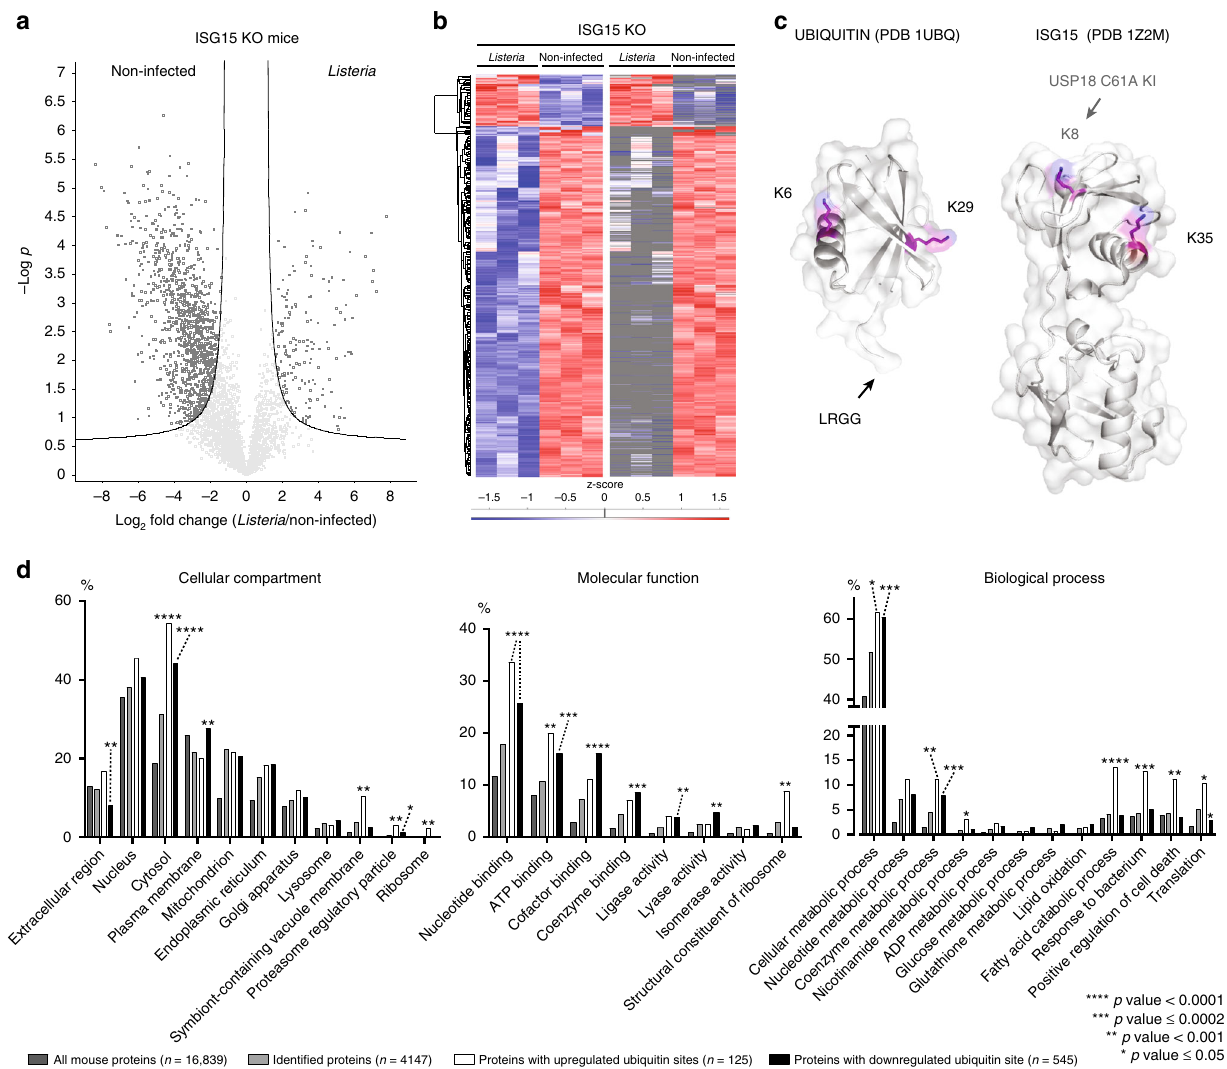
Fig. 3 Loss of ubiquitin sites following infection and evidence for mixed ISG15/Ubiquitin chains. a Volcano plot showing signi fi cantly regulated ubiquitin sites upon Listeria infection of Isg15 − / − animals. The fold change (in log2) of each GlyGly(K) site is shown on the x -axis, while the statistical signi fi cance ( − log P -value) is shown on the y -axis. In total, 168 GlyGly(K) sites were signi fi cantly upregulated during infection, while 1138 sites were downregulated (Supplementary Data 3). b Heatmap representation of signi fi cantly up- and downregulated ubiquitin sites after non-supervised hierarchical clustering. On the right side, the heatmap is shown with missing values in gray (Supplementary Data 4). c Crystal structures of ubiquitin and ISG15 with modi fi ed lysines highlighted. K6 and K29 of ubiquitin are modi fi ed following bacterial infection in wild-type animals. K35 of ISG15 is modi fi ed following bacterial infection in wild-type animals, and K8 is modi fi ed following infection in USP18 C61A/C61A animals. d GO cellular compartment analysis of ubiquitylated proteins (clusters 3 and 4) relative to all proteins identi fi ed in the analysis (light gray) and all mouse proteins in the Uniprot/Swiss-Prot database (dark gray). Bars correspond to the percentage of proteins annotated with each GO term. Asterisks indicate signi fi cant enrichment relative to the number of identi fi ed proteins (two-sided Fisher's exact